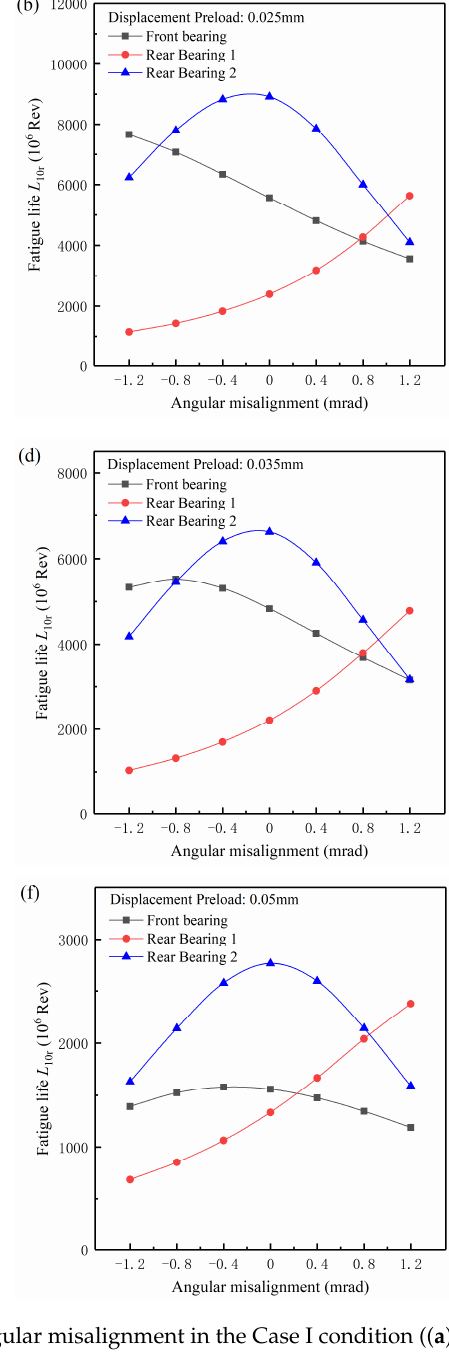
Figure 12. The contact force distribution in Rear Bearing 1 at the optimal angular misalignment of the shaft-bearing system. The preload displacements are 0.025 mm (( a ) and ( b )) and 0.035 mm (( c ) and ( d )), respectively. 5.2. The Constant-Force Preload Condition Figure 13 shows the variation of bearing life with the angular misalignment in the constant-force preload condition. In order to analyze the effects of the preload method on the bearing life, the preload force was taken as 500 N, 1000 N, and 1500 N. When the shaft was running without external loads, the preload force of 500 N could cause 0.0355 mm axial displacement of the